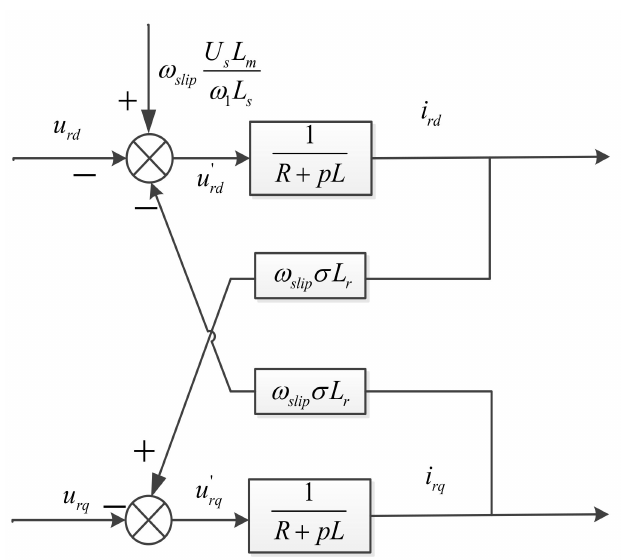
Figure 6. The dq current inner loop control of